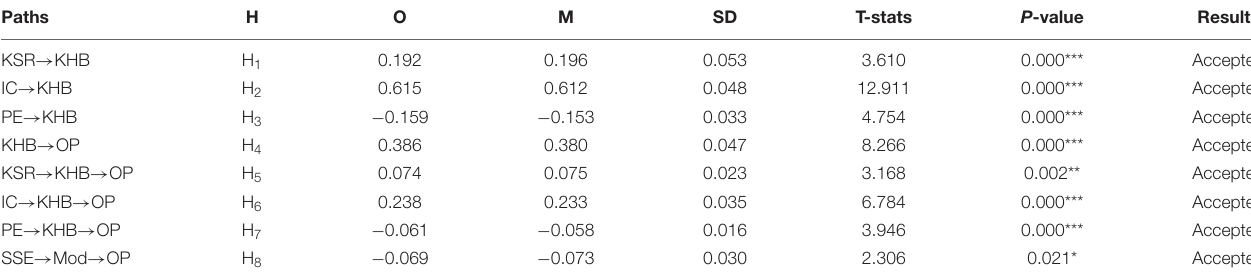
TABLE 5 | Results for structural model.